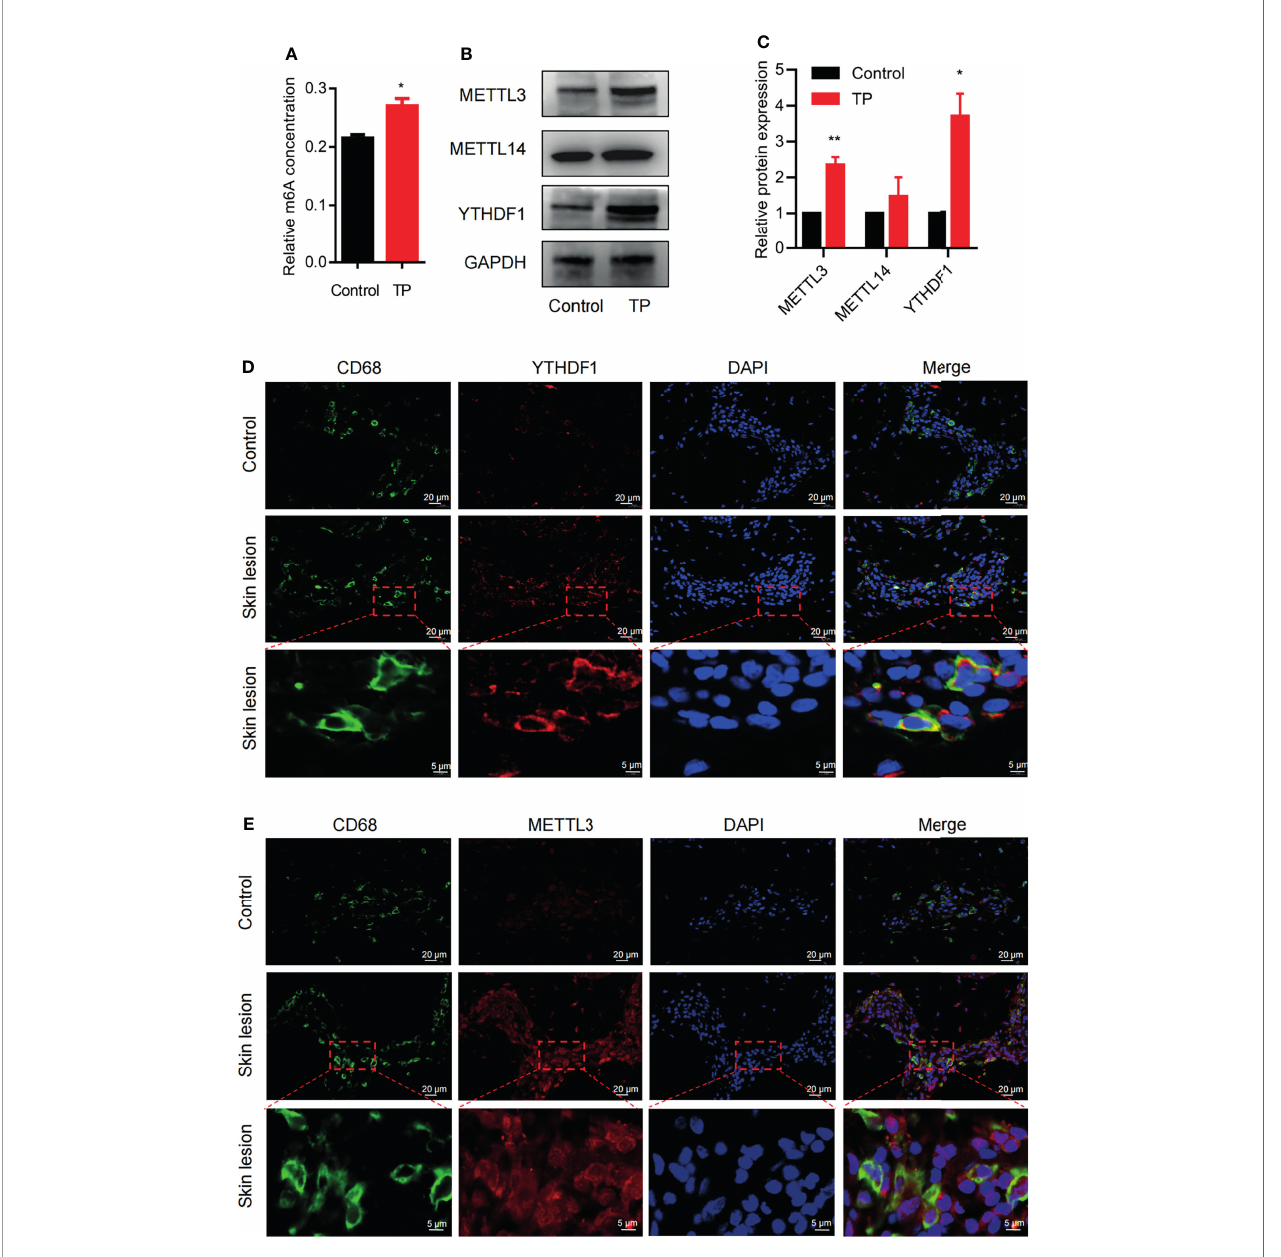
FIGURE 1 | m6A methylation: the m6A writer METTL3 and the reader YTHDF1 are upregulated in TP-infected macrophages. (A) Colorimetric quanti fi cation of m6A methylation in RNA from THP-1 cells with or without TP infection. (B, C) Western blot analysis of METTL3, METTL14, and YTHDF1 in THP-1 cells with or without TP infection. GAPDH was used as a control. *P < 0.05, **P < 0.01. (D, E) Immuno fl uorescence analysis of YTHDF1 or METTL3 in CD68+ macrophages in secondary syphilitic lesions and paired non-lesional skin tissue. Scale bar: 20 m m or 5 m